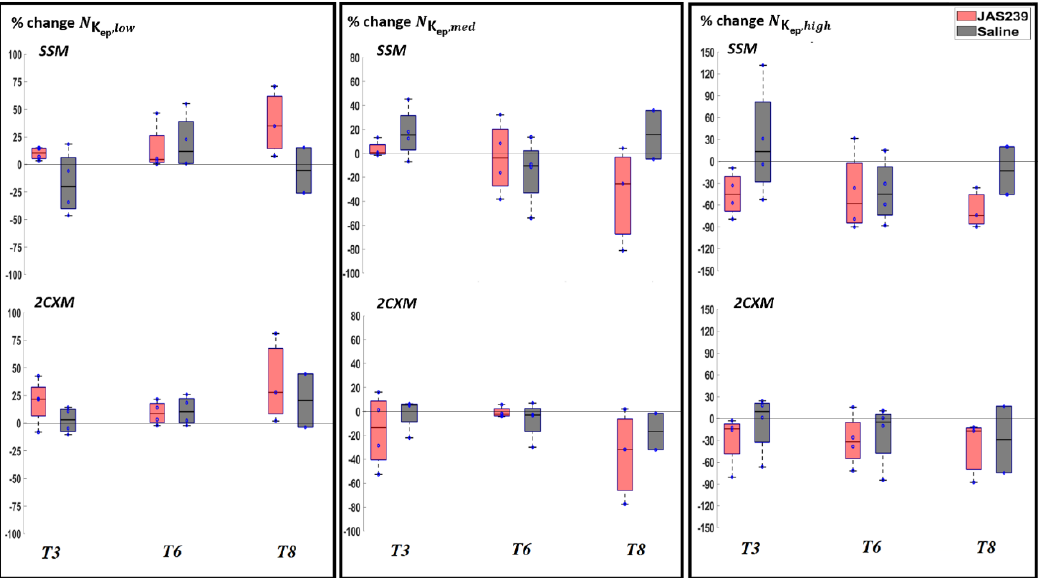
Figure 6. Box plot for percentage change (with respect to baseline) in 𝑁 Kep,𝑦 (where 𝑦 = low, med and high) in F98 rat GBM with JAS239 (red) and saline (grey) treatment at different time points using the SSM (top) and 2CXM (bottom) models, respectively.